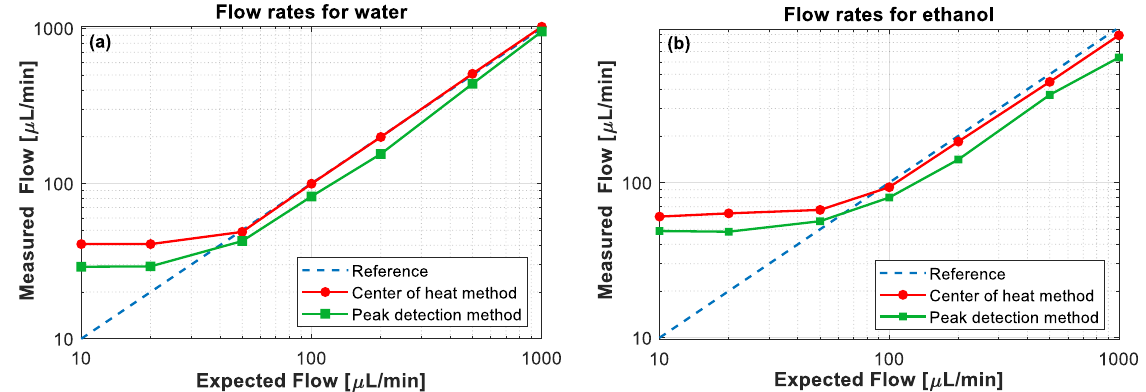
Figure 6. Volumetric flow rates deduced by both the peak detection and the center of heat methods described in Section 2.3 for ( a ) water and ( b ) ethanol. The blue dashed lines show the expected volumetric flow rates, while the red and green curves indicate the measured flow rates obtained by the center of heat and peak detection methods, respectively. Flow rate detection limits are approximately 70 µL/min for ethanol and 40 µL/min for water. At low flow rates, two factors contribute to this limit: diffusion becomes the dominant method of heat transfer, causing broadening of the heat pulse and low displace- ment of the heat results in limits by the quantization of the time–distance domain of the